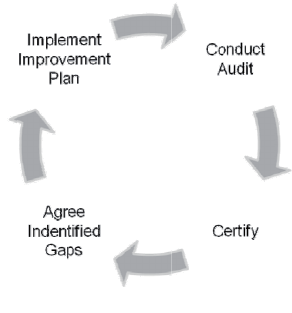
Fig. 7 – Continuous process of service excellence. Source: